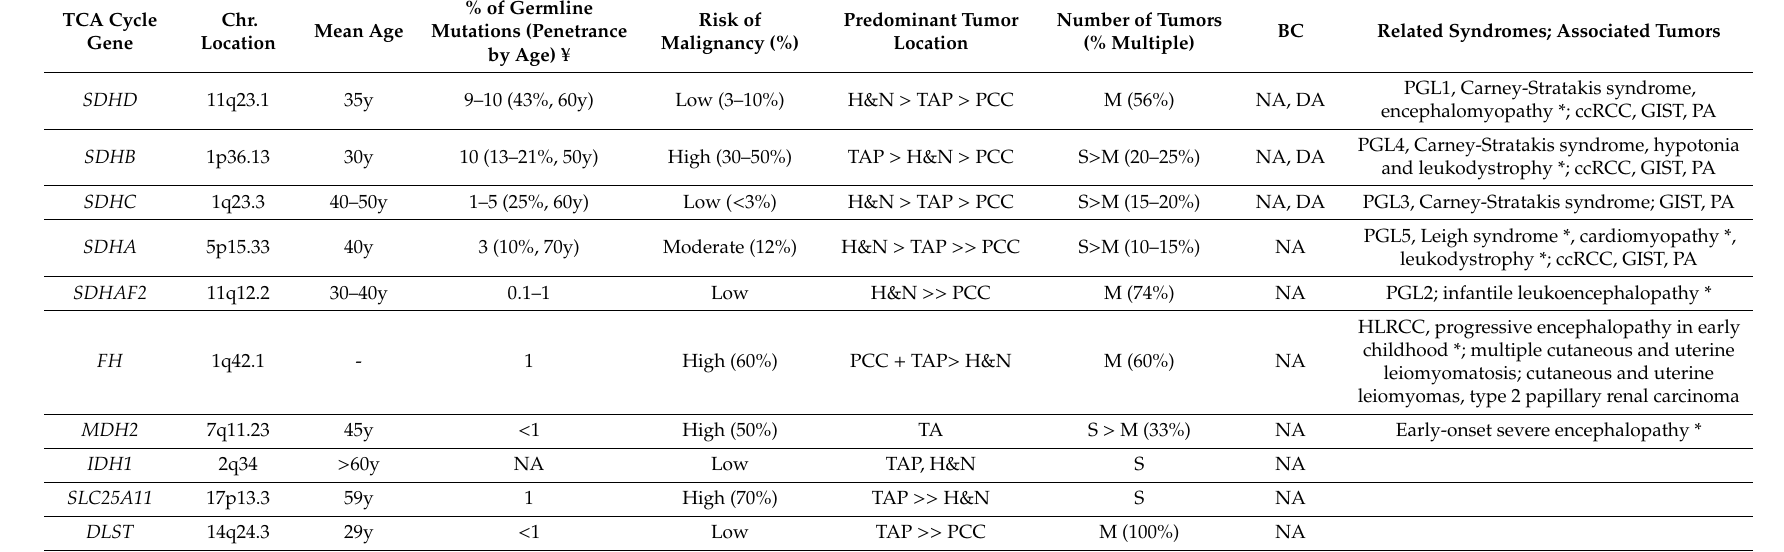
Table 1. Summary of phenotypic and genetic features associated with the TCA cycle-related PPGL